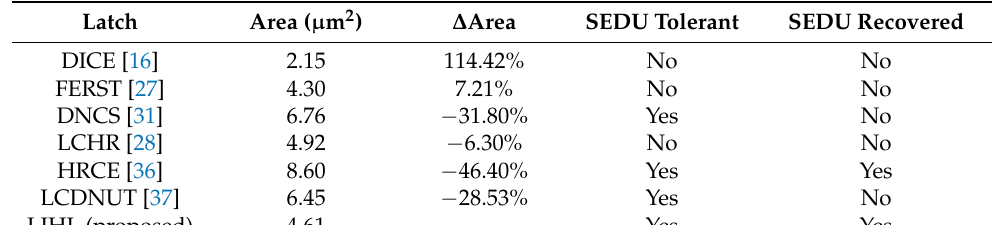
Table 3. Area Comparison.